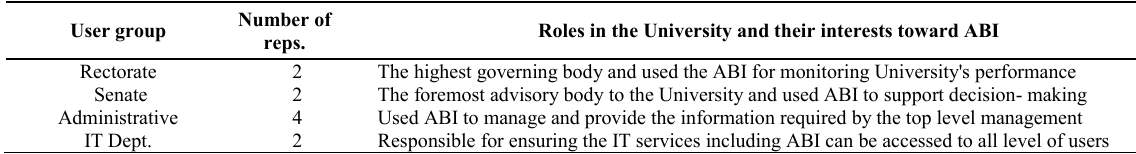
TABLE 3 USER GROUP PARTICIPANTS AND THEIR ROLES IN THE UNIVERSITY